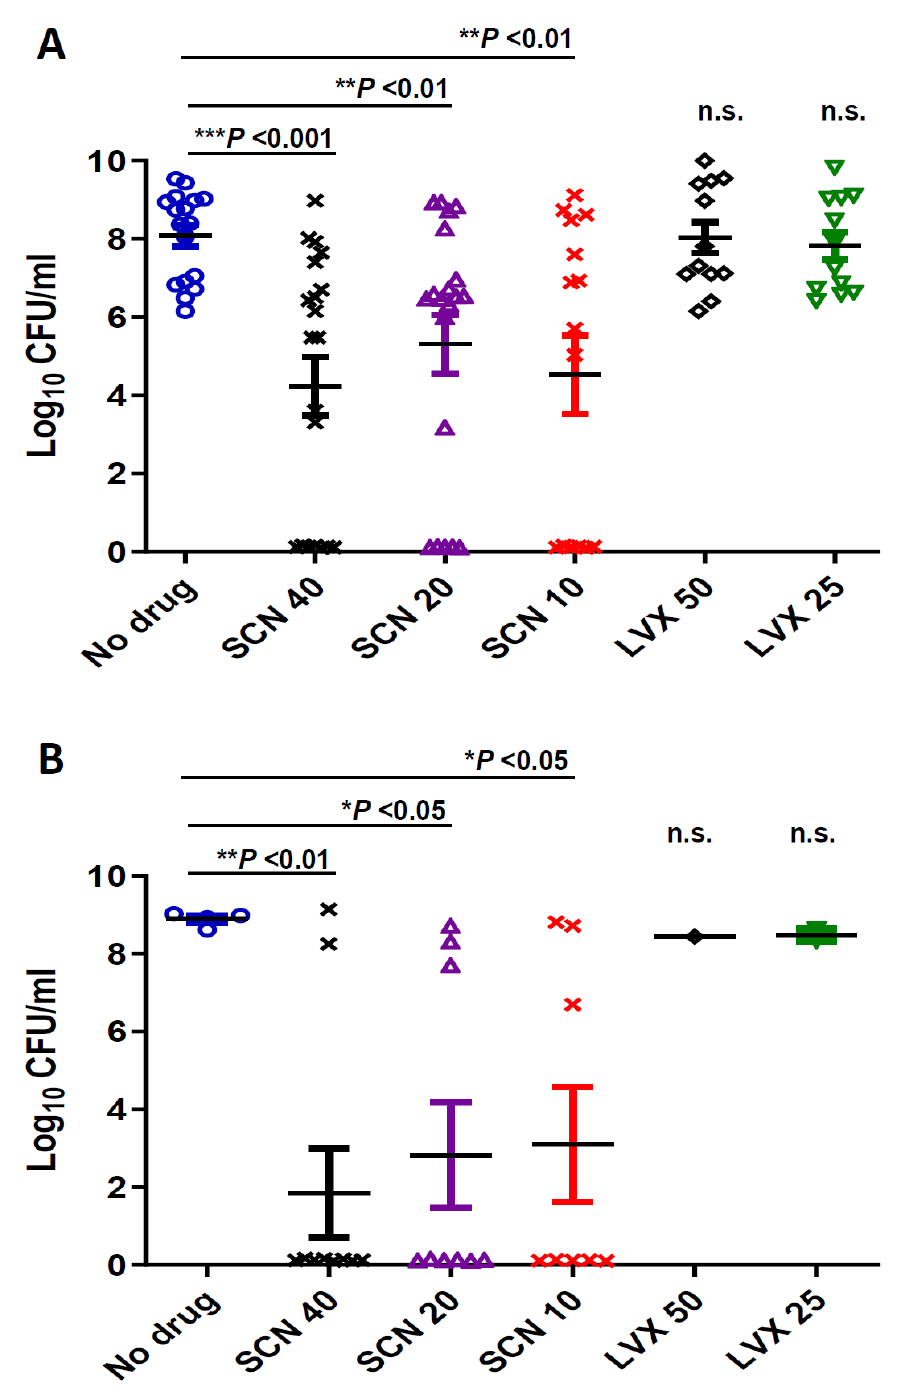
Figure 2. Determination of bacterial counts in the blood of at least 10 mice. To measure the level of bacteria in the bloodstream, blood samples were collected from the tail of the mice of each group at ( A ) 24 h or ( B ) 48 h after infection, plated on blood agar and incubated at 37 °C in 5% CO 2 for 24 h. Data are the average of 3 independent replicates. The t -test was used to estimate the difference between the treated groups and the untreated (no drug) group. The symbols for p values are: * p < 0.05; ** p < 0.01, *** p < 0.001 and n.s.: not significant. For multiple comparisons of the different doses of SCN (one-way ANOVA with a post hoc Dunnett test); p < 0.01 and p < 0.05 for 24 h ( A ) and 48h ( B ) respectively. The comparison of different doses of SCN with LVX was statistically significant at 24 h when the majority of mice were alive ( p < 0.01 for SCN 40 vs. LVX 50 and 25; p < 0.05 for SCN 20 vs. LVX 50 and 25 and p < 0.01 for SCN 10 vs. LVX 50 and 25).